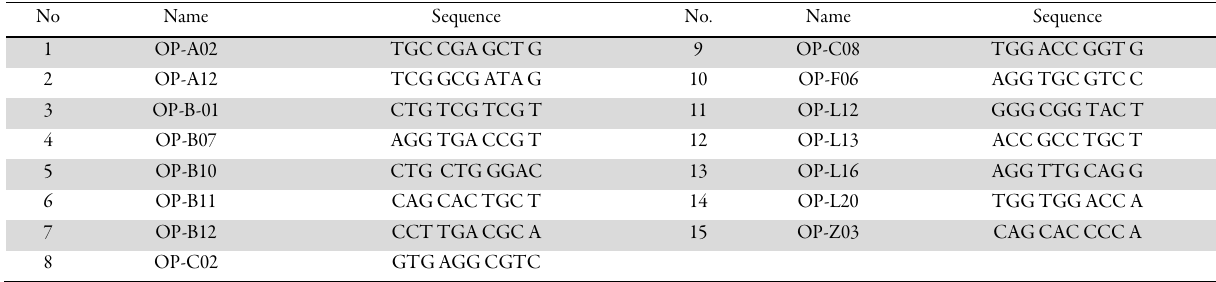
Table 1. The list of primer’s names and their sequences